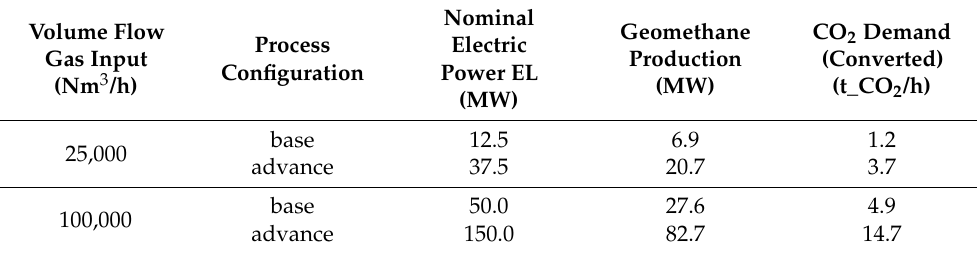
Table 2. Nominal electric power of the electrolyser and CH 4 production related to the plant size (volume flow gas input) and process